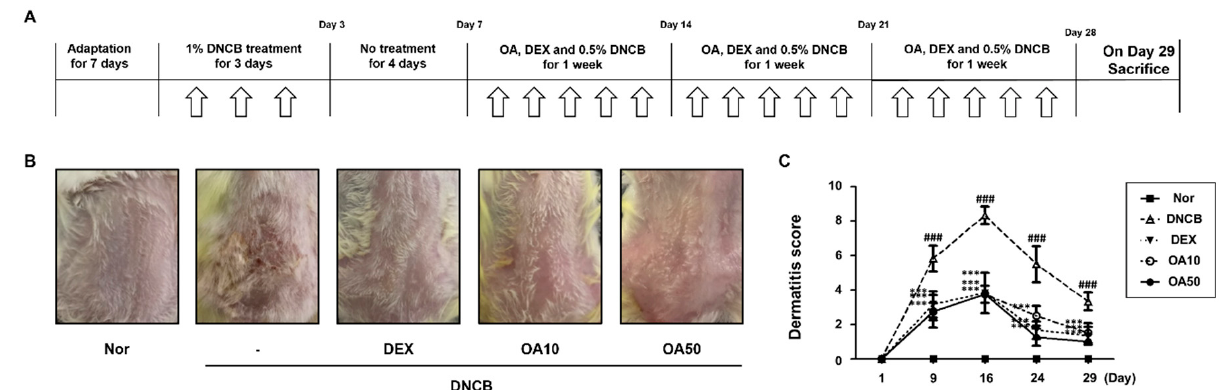
Figure 1. Effects of OA on DNCB-induced AD skin lesions in ICR mice. ( A ) Experimental schedule for the induction of AD. ( B ) Effect of OA on clinical features of DNCB-induced AD skin lesions. White arrows indicated DNCB treatment. ( C ) Effects of OA on dermatitis score. Densitometric analysis was performed using Bio-Rad Quantity One ® Software. The data shown represent mean ± S.D. ( n = 6) of three independent experiments. ### p < 0.001 vs. the control group; *** p < 0.001 vs. DNCB-treated group.